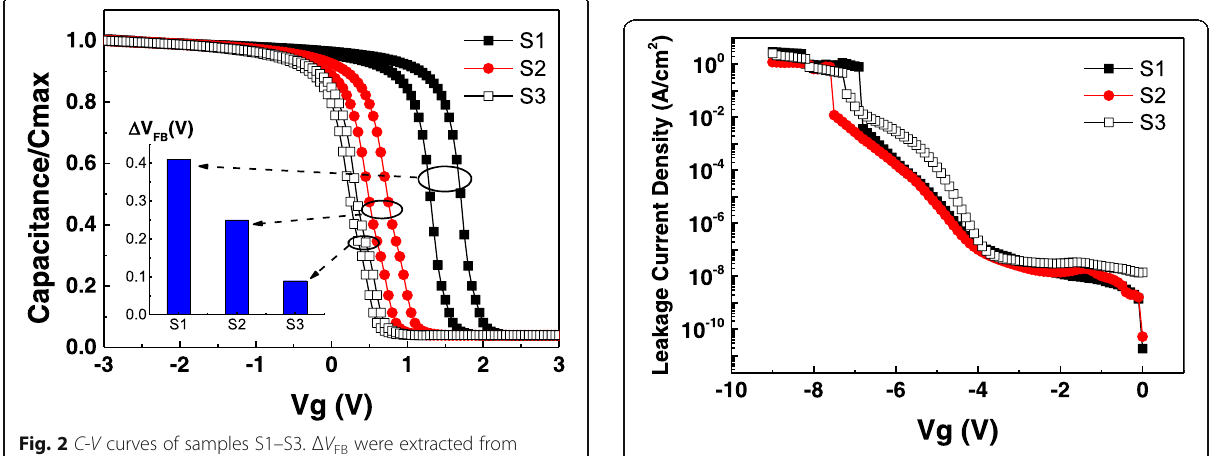
Fig. 4 I - V curves of samples S1 – S3